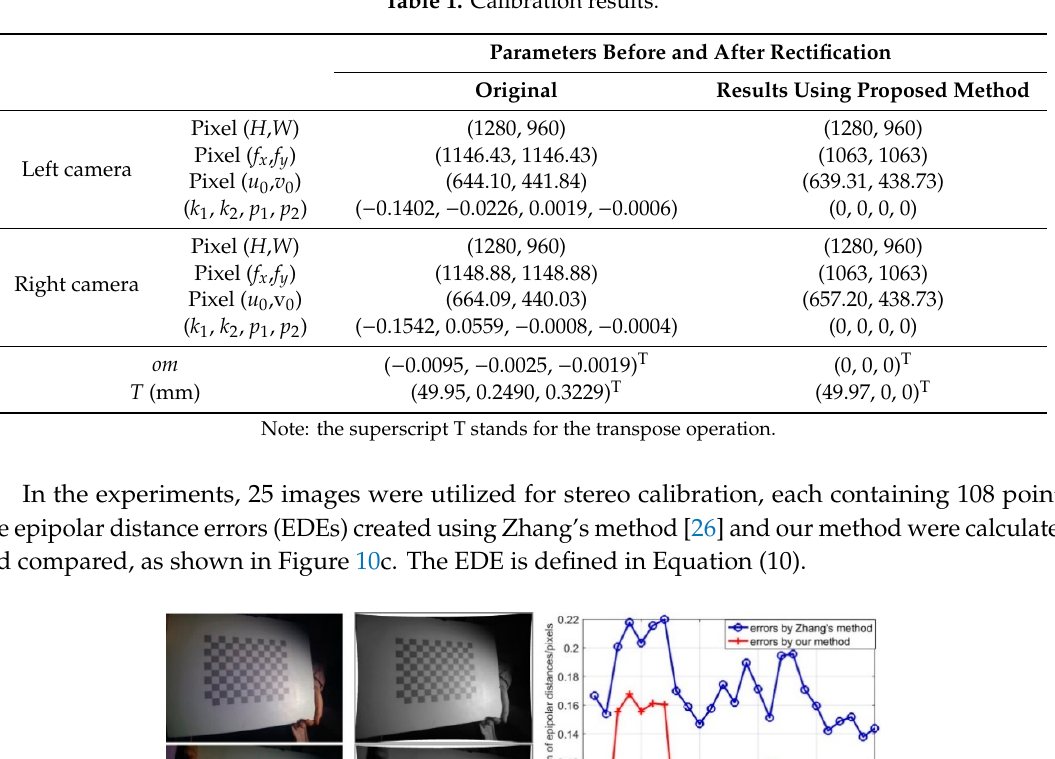
Table 1. Calibration results.